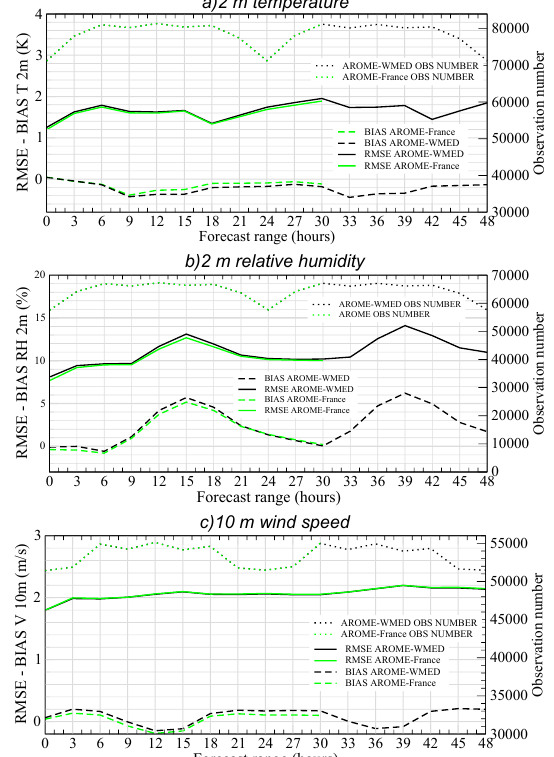
Figure 16. Bias (dashed lines) and root mean square errors (RMSE; solid lines) computed with 2m temperature observations (a) , 2m relative humidity (b) and 10m wind (c) with respect to the forecast range for the AROME-WMED model (black) and the AROME-France model (green) for SOP2 from 01 February to 15 March 2013. Dotted lines denote the number of observations used for the comparison (right y